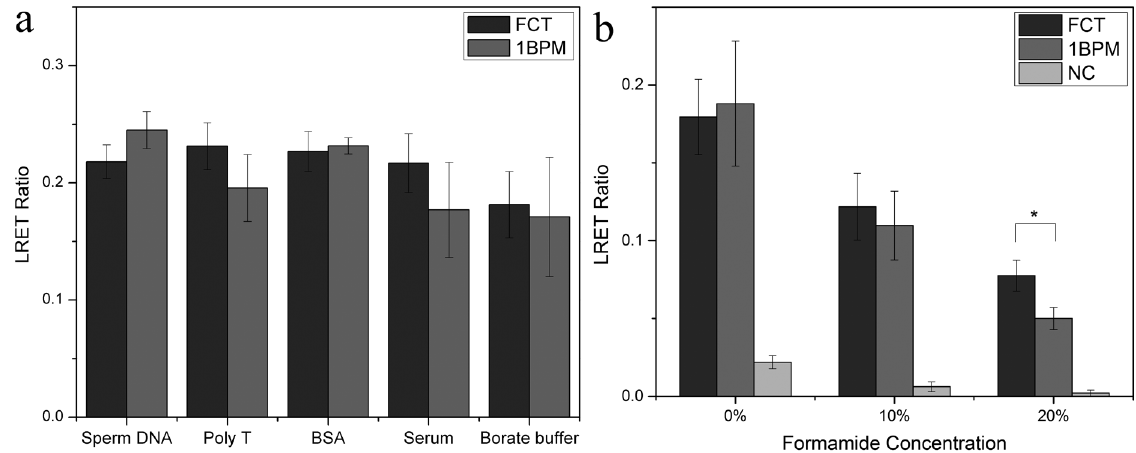
Figure 5. Evaluation of hybridization selectivity by detection of FCT and 1BPM target spiked in solutions containing different types of interferents; ~3.1 × 10 − 6 mol/L sheared salmon sperm DNA, 3.5 × 10 − 6 mol/L Poly T (T30) solution, 4.0 × 10 − 4 mol/L BSA, and undiluted goat serum. The final concentration of the spiked FCT target in the solutions was maintained at 0.5 × 10 − 6 mol/L ( a ); Evaluation of selectivity of the hybridization assay for FCT and 1BPM targets spiked in undiluted serum using various concentrations of formamide ( b ) ( n =